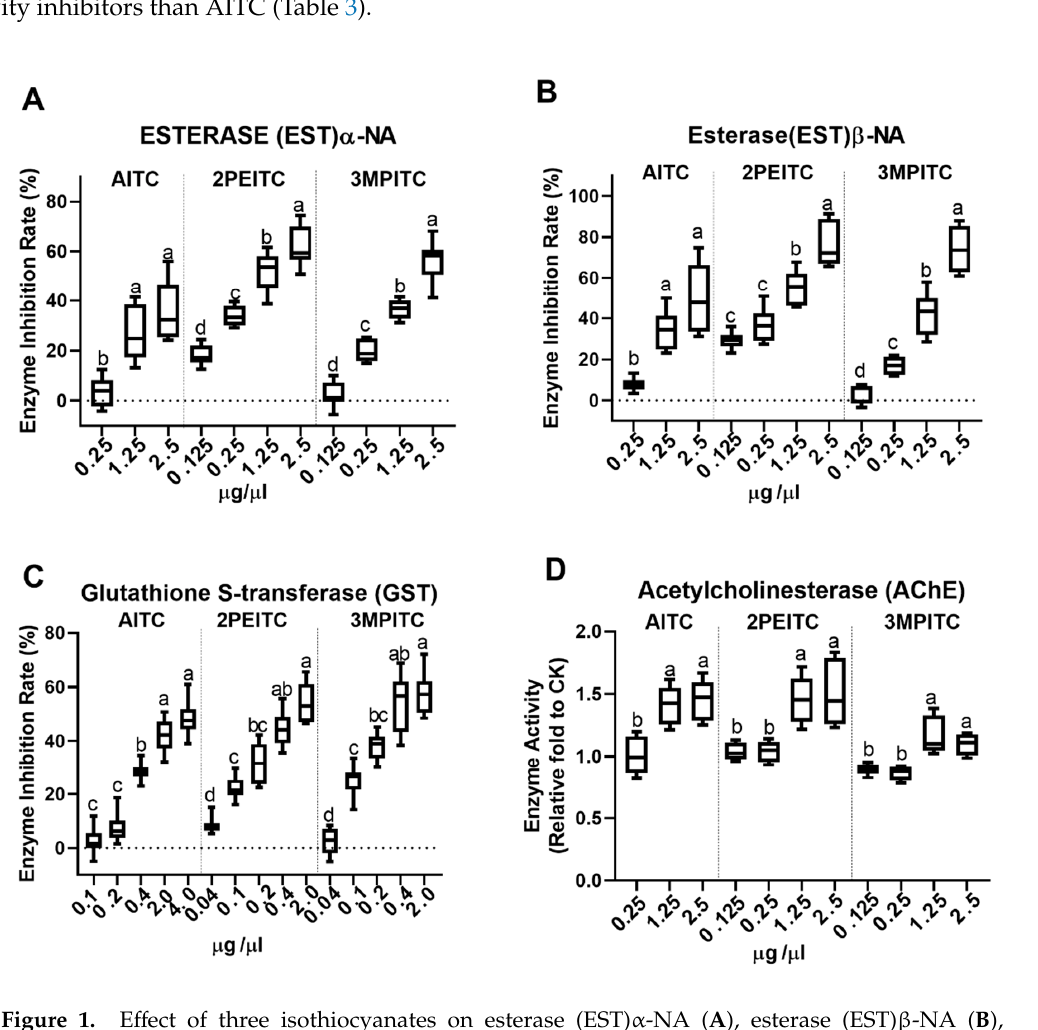
Figure 1. Effect of three isothiocyanates on esterase (EST) α -NA ( A ), esterase (EST) β -NA ( B ), glutathione S -transferase (GST) ( C ) and acetylcholinesterase (AchE) ( D ) activities in red imported fire ants, Solenopsis invicta . To obtain the homogeneous variance, some percentage of inhabitation rate was